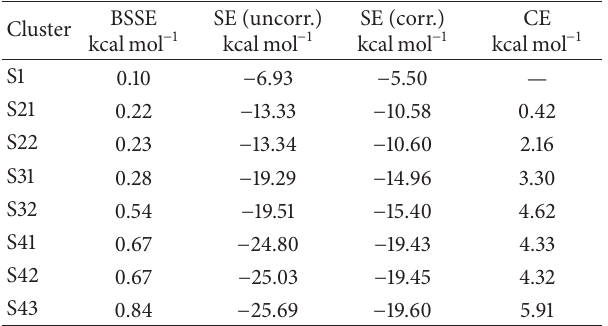
Table 1: BSSE, stabilization energy corrected with ZPE, uncor- rected stabilization energy, and cooperative effect (CE) calculated at MP2/6-311++G(d,p).